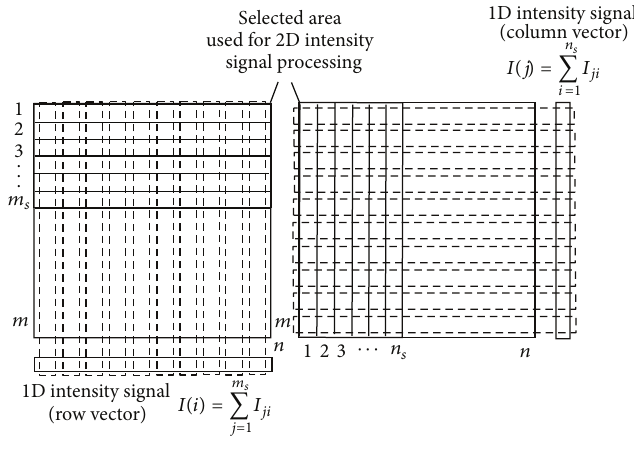
Figure 4: Illustration of 2D intensity signal processing for selected area of a detector.